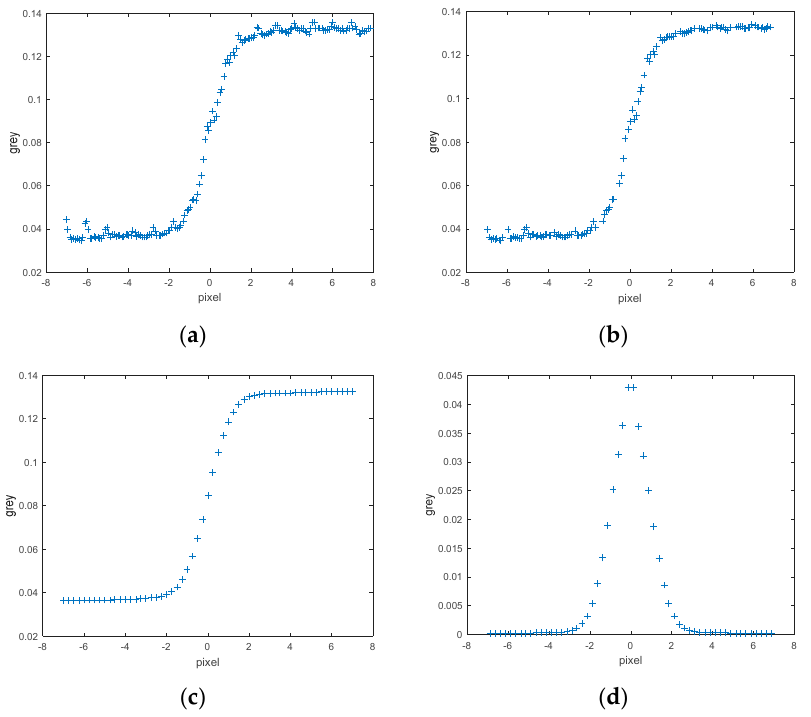
Figure 9. ( a ) Results of ESF sample; ( b ) ESF denoised sample; ( c ) ESF resample; ( d ) LSF sample.